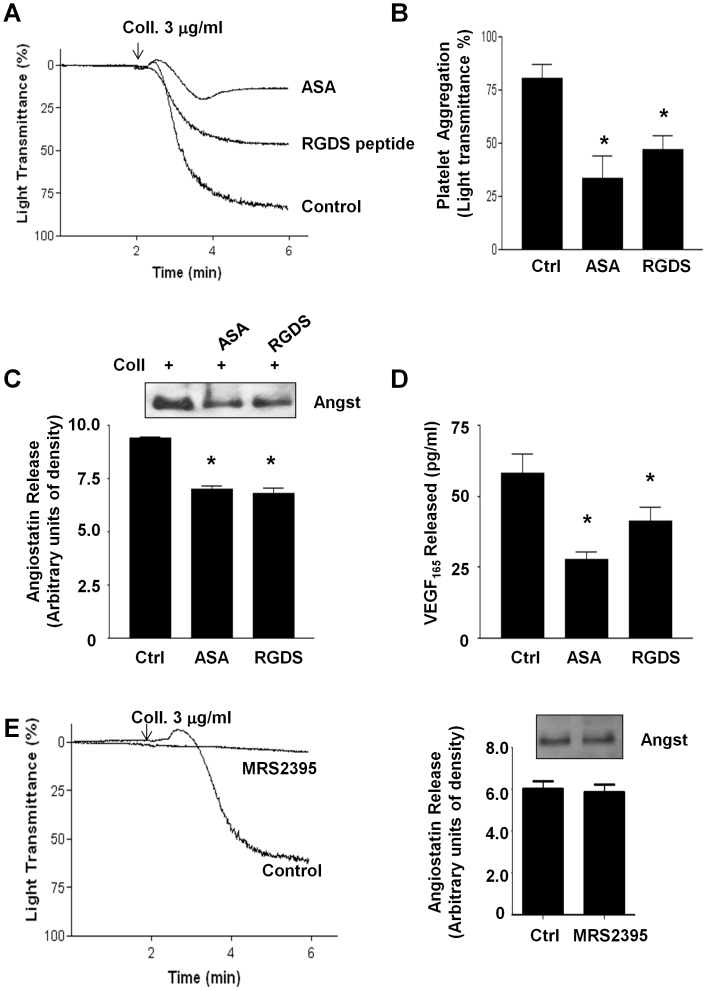
Effect of anti-platelet agents on angiostatin release.(A) Represenative traces and (B) summary data demonstrating the inhibitory effects of ASA (100 µM) and RGDS (10 µM) on platelet aggregation. (C) Represenative immunoblot and summary densitometry data demonstrating the inhibitory effects of ASA (100 µM) and RGDS (10 µM) on platelet angiostatin release. (D) Summary data demonstrating the inhibitory effects of ASA (100 µM) and RGDS (10 µM) on platelet VEGF release. (E) Represenative traces demonstrating the inhibitory effects of MRS2395 (50 µM) on platelet aggregation. (F) Represenative immunoblot and summary densitometry data demonstrating that MRS2395 does not inhibit angiostatin release. N = 4. *, P<0.05 vs. control. Angst – Angiostatin.